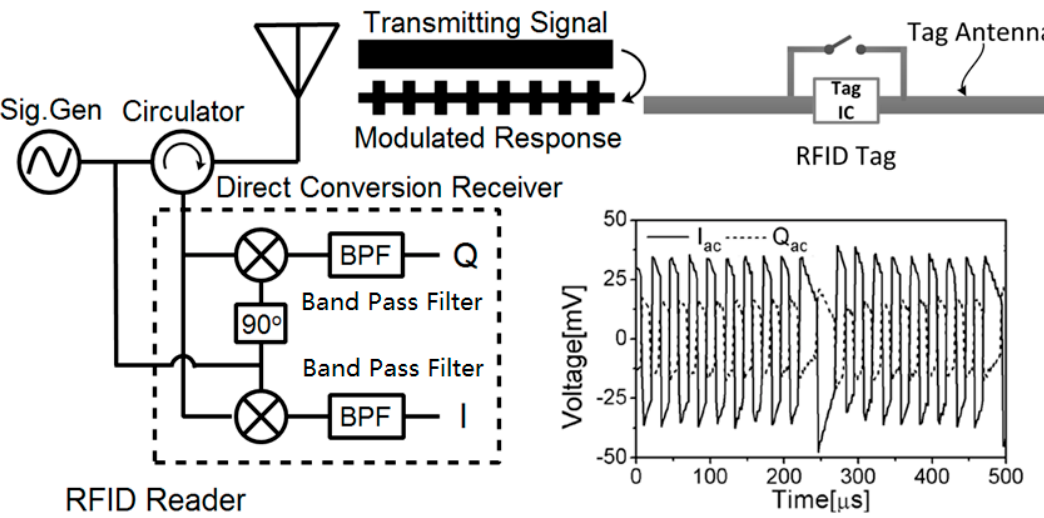
Figure 2. Ultrahigh-frequency (UHF) RFID system block diagram.